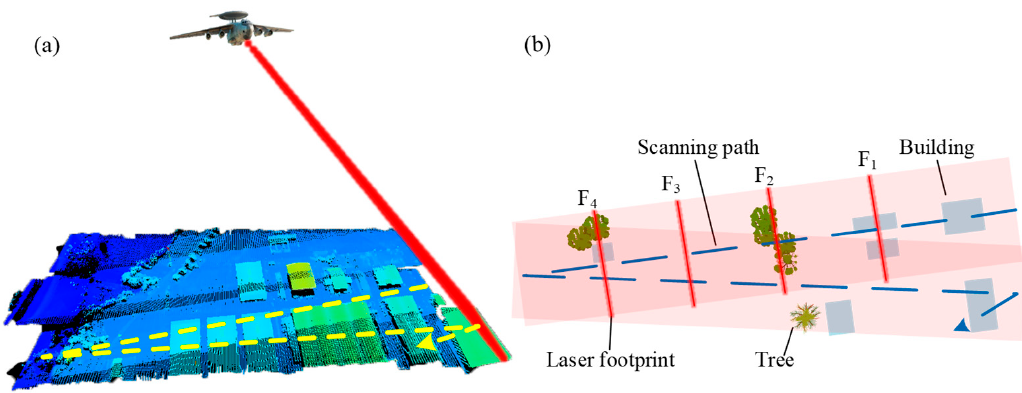
Figure 1. ( a ) ASTIL scanning mechanism [18]; ( b ) ASTIL footprint scanning trajectory.